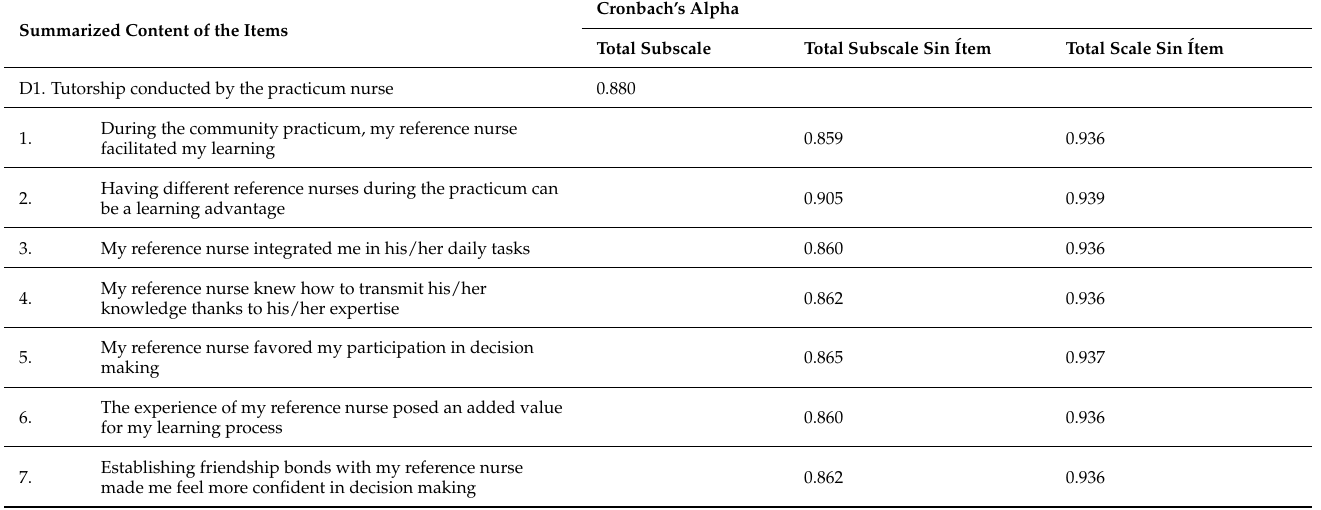
Table 3. Internal consistency coefficient (Cronbach’s alpha) of the Questionnaire of Perception toward the Clinical Learning Process (QPCLP)